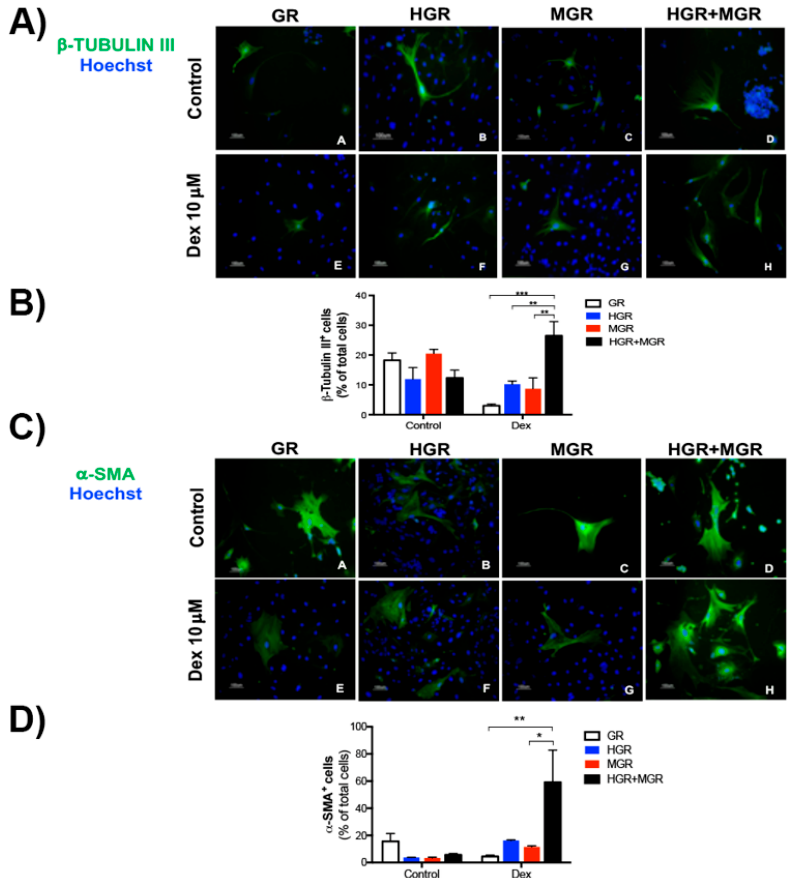
Figure 8. Activation of HGR and MGR nuclear translocation in double transgenic cells increases the number of differentiated β -TUBULIN III- and α -SMA-positive cells. Cells were differentiated under control conditions or with 10 µ M Dex for 10 days and immuno-stained with anti- β -TUBULIN III antibody ( A ). ( B ) Quantification of the number of β -TUBULIN III + cells. Double-transgenic cells produced a higher proportion of neurons compared with GR, MGR, or HGR cells. ( C ) Immunostaining with anti- α -SMA antibody after differentiation under control and dexamethasone-added conditions. ( D ) Quantification of large α -SMA-positive cells with a filamentous aspect. Double-transgenic cells produced a higher proportion of smooth muscle cells compared with GR and MGR cells. Experiments were performed in triplicate; pictures were taken in at least ten fields from three independent experiments. The mean ± SEM is presented. Statistical analysis of all conditions was conducted with ANOVA followed by Tukey’s multiple comparison test and only the significant differences are indicated in the graph. * p < 0.05, ** p < 0.01, and *** p < 0.001.